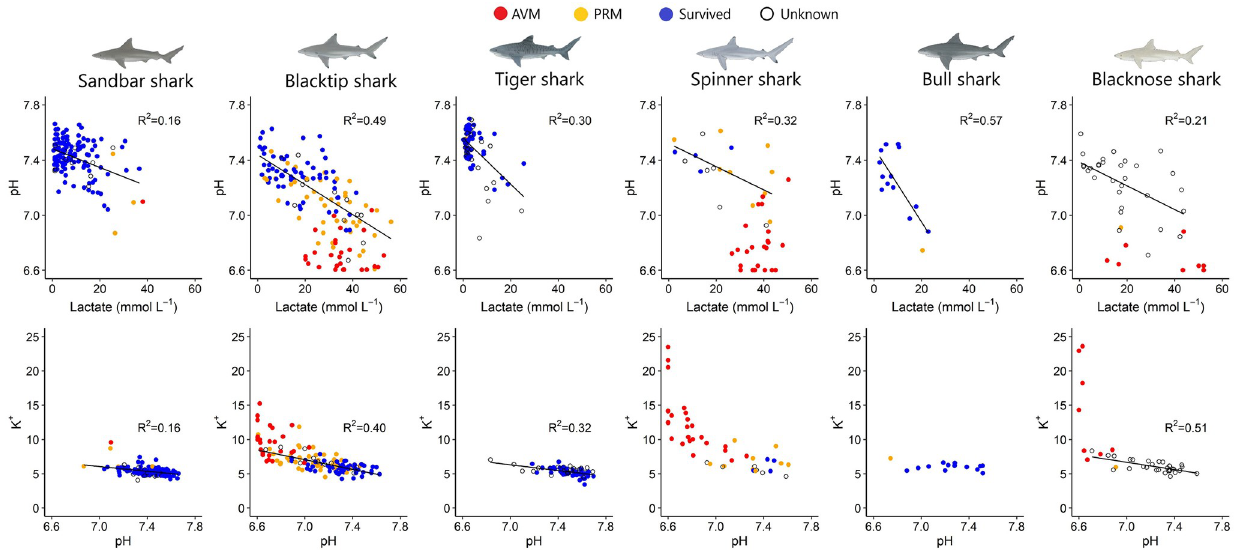
Fig 4. Relationships between blood parameters describing the reaction to capture stress experienced by each species of shark. Linear trendlines are drawn where significant relationships between parameters were determined. Data from all sharks where blood was taken were included in the plots, including from sharks that were at-vessel mortalities (AVM), post-release mortalities (PRM), sharks that survived the capture process (Survived) and sharks which were alive at vessel but with the post-release fate unknown (Unknown). However, only sharks that were alive at the time of capture were used to test significance of relationships between parameters and form trendlines as it was unknown how long AVM sharks had been dead at the time of sampling.